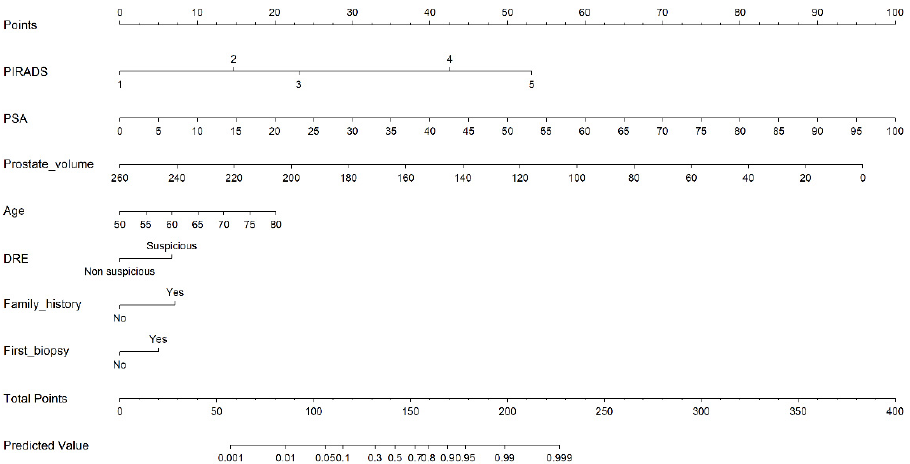
Figure 3. Nomogram derived from the developed MRI-PM model of csPCa in prostate biopsies. CUCs showing the rate of avoidable biopsies and the corresponding rate of poten- tially missed csPCa, regarding the continuous csPCa probability threshold, are presented in Figure 4.